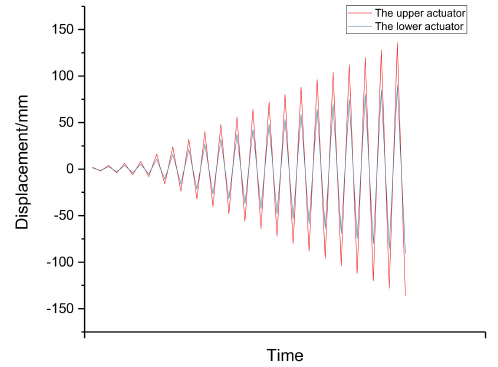
Figure 5. History of loading